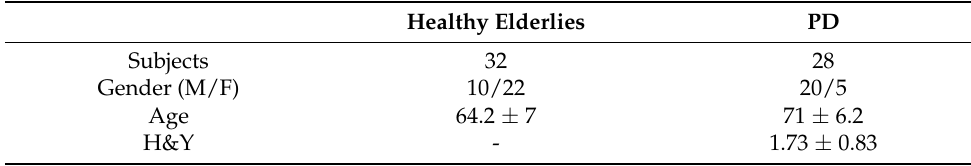
Table 1. Subjects’ characteristics—phase 1.